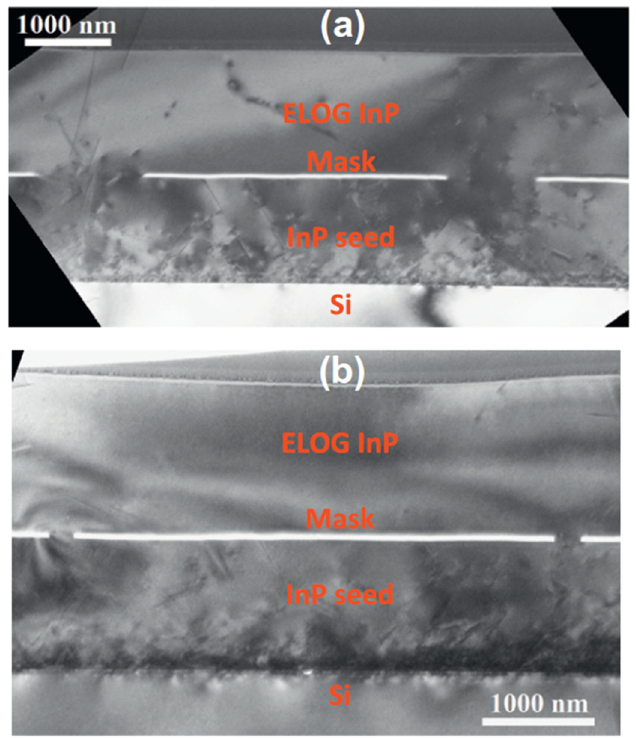
Figure 11. TEM cross-sectional view of ELOG InP on Si; ( a ) mask opening width was larger than the thickness of the mask; ( b ) mask opening width was small to filter dislocations. Reprinted with permission from ref. [56] © Elsevier. Copyright 2012 Current Opinion in Solid State & Materials Science.